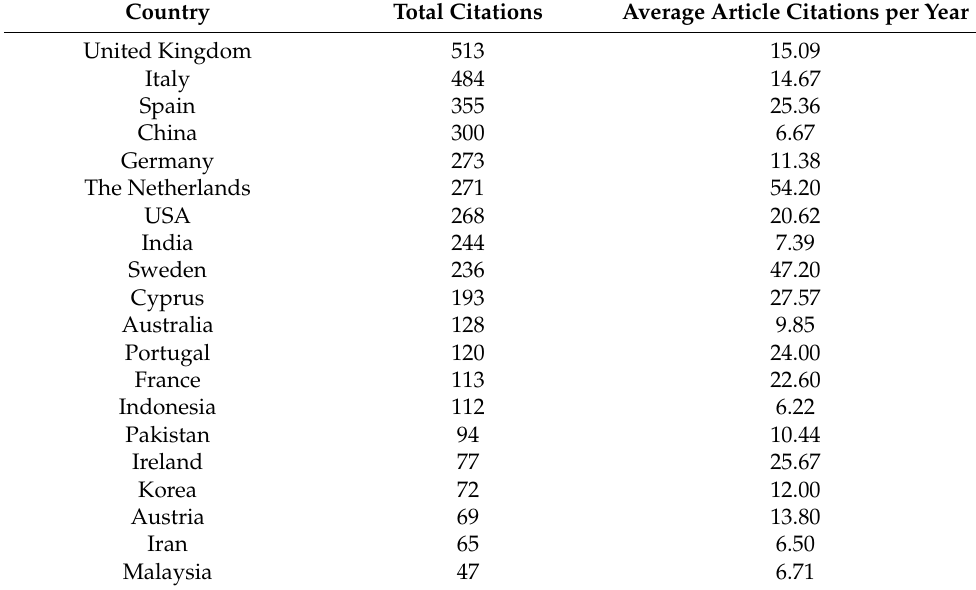
Table 2. Scientific production of the main countries related to the smart and precision